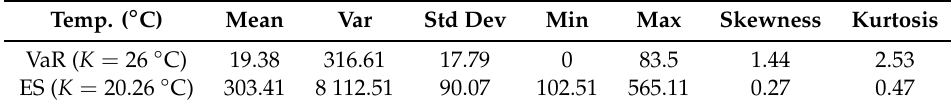
Table A2. Descriptive Statistics for seasonal CDDs for the period of time 1970–2016 and 90% percentile threshold.